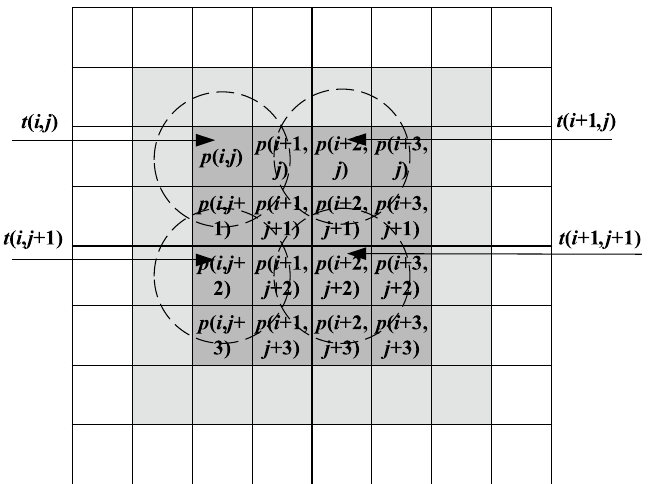
Figure 5. Multi-point access within a work-group.